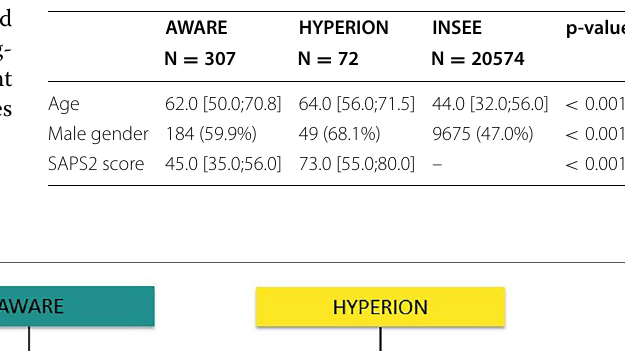
Table 1 Baseline characteristics according to patients’